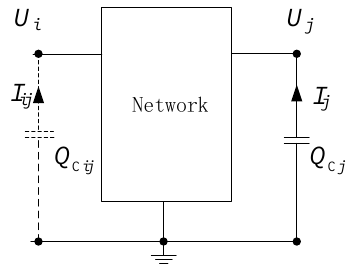
Figure 3. Schematic diagram of converting the shunt capacitor’s capacity from bus j to bus i .